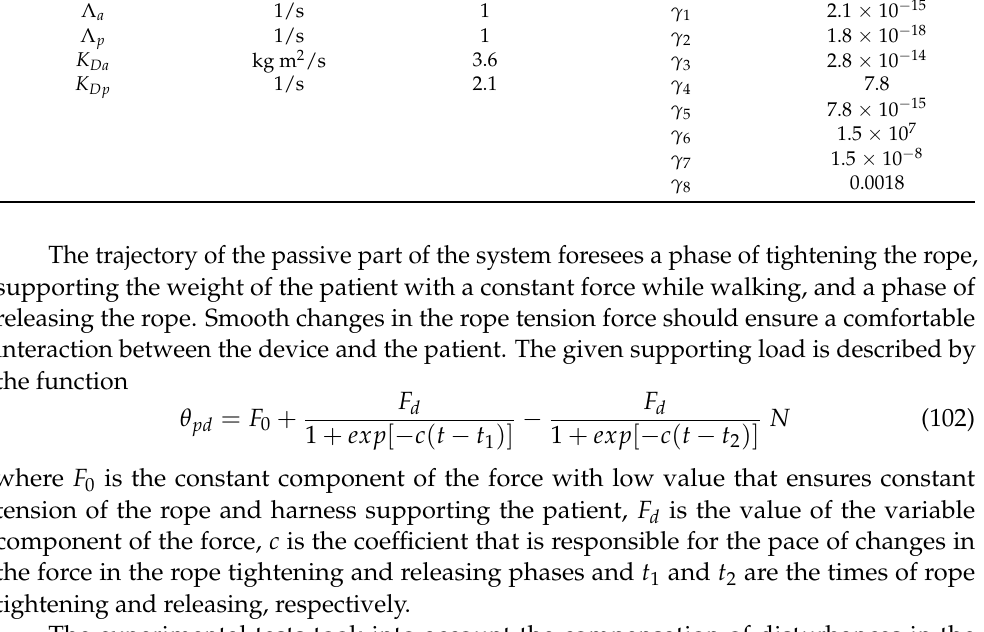
Figure 12. Rope reaction force realized with the use of the algorithm based on the mathematical model and the adaptive algorithm.